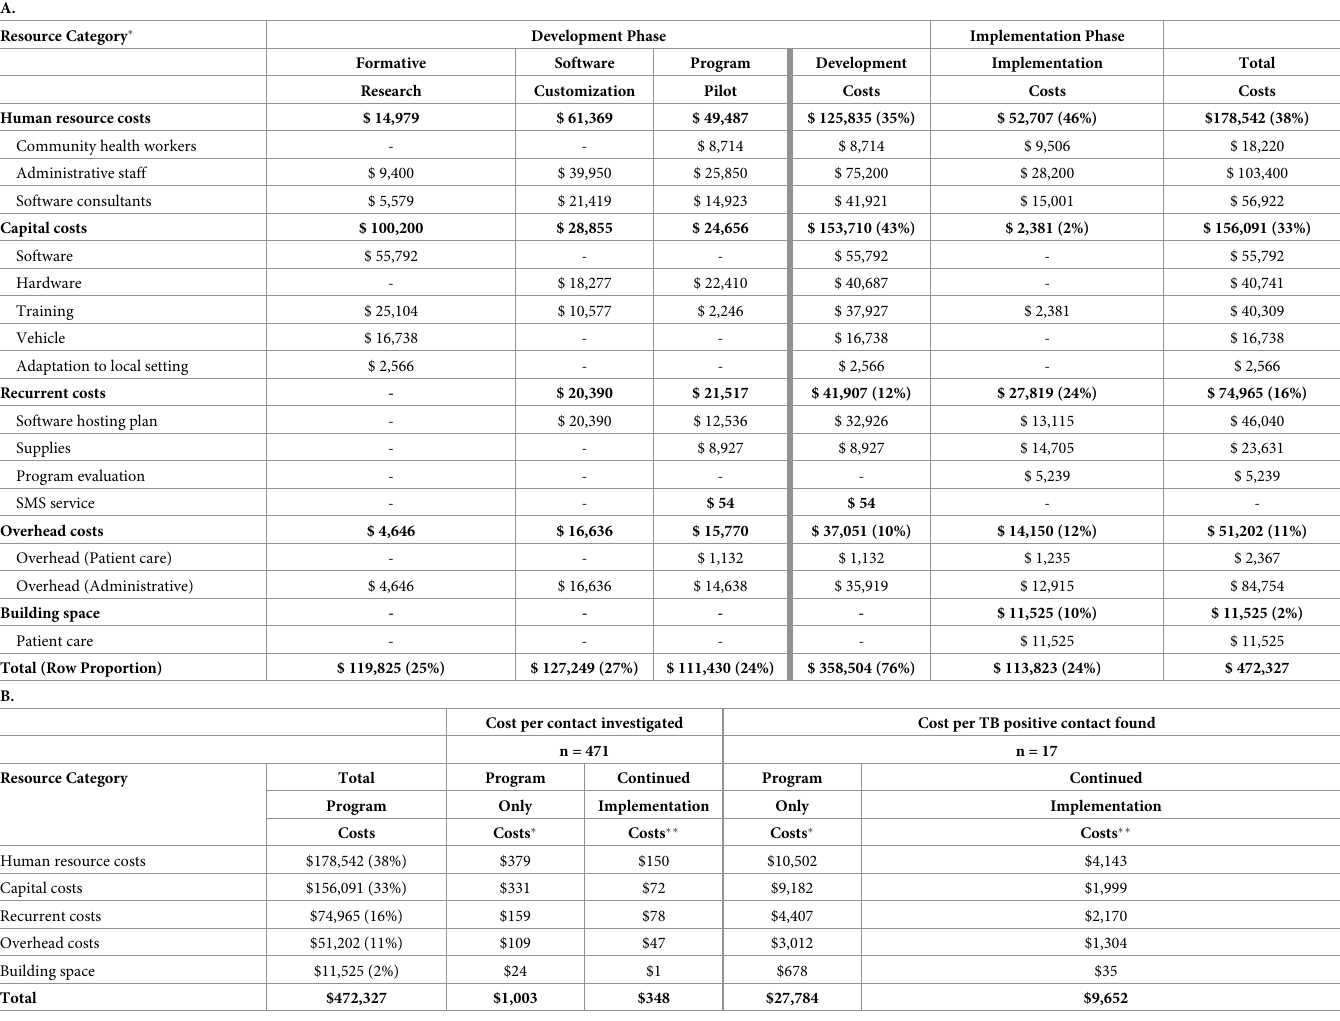
Table 2. a. Granular unit cost estimates for each phase of implementation of an mHealth-facilitated TB contact investigation program. b. Top-down cost estimates for household contact investigation of tuberculosis in Uganda. A.